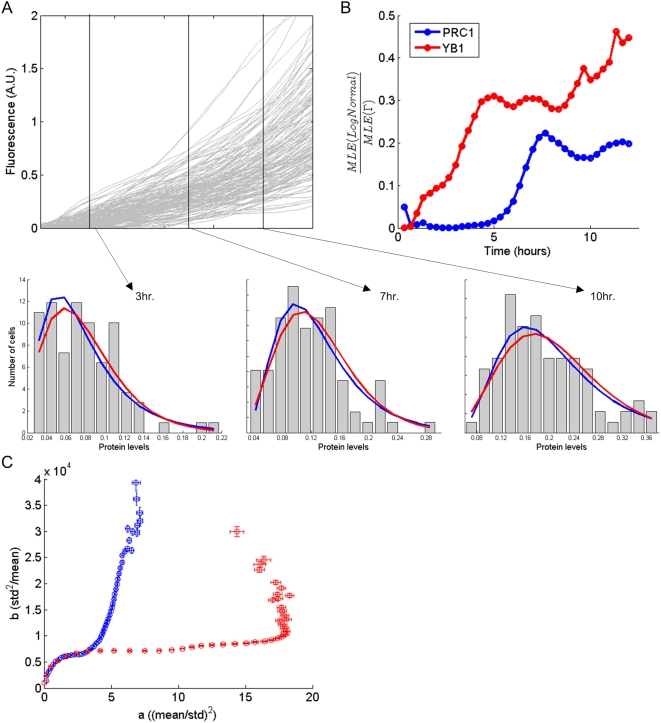
Cell–cell protein distributions match theoretical prediction of Gamma distributions with time-dependant parameters.(A) Example of cell tracks (each line denotes PRC1-tagged fluorescence measured in a single cell), Distributions of fluorescence levels at 3, 7 and 10 hours following accumulation onset are shown. Fit to log-normal (red) and Gamma (blue) distributions are overlaid. (B) Ratio between maximum likelihood estimation (MLE) of log-normal and gamma distributions was computed at a temporal resolution of 20 minutes for PRC1 (blue) and YB1 (red). Cell-cell distributions fit Gamma distribution better (ratio<1) across the cell cycle. (C) Variation of the effective Gamma distribution parameters a (scale), and b (shape). These parameters are related to the mean, μ, and standard deviation, σ, by  and . Bold blue and red circles denote a,b measurements for YB1 and PRC1 respectively for the first 12 hours of protein accumulation. Error bars denote standard errors.